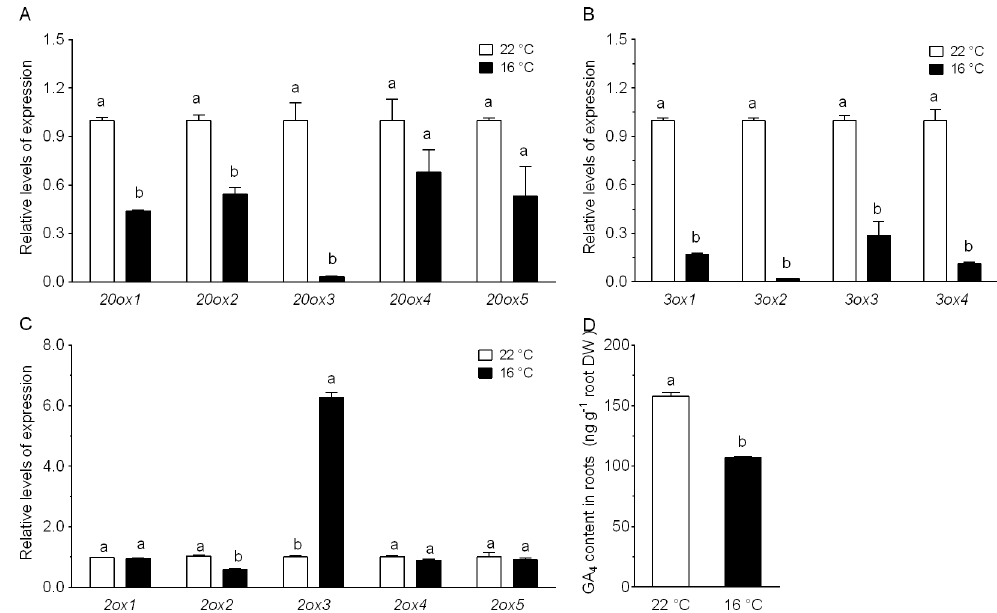
Fig 3. Suboptimal T r regulates the transcript levels of GA biosynthesis genes. (A) Expression profiles of GA biosynthesis GA 20-oxidase genes. (B) Expression profiles of GA 3-oxidase genes. (C) Expression profiles of GA 2-oxidase genes. (D) Determination of GA 4 concentration in cucumber roots. 10-day-old seedlings were treated with 22°C T r or 16°C T r for 5 d. Data are means ± SE. Different letters on the top of column indicate significant differences ( P < 0 . 05 , n =